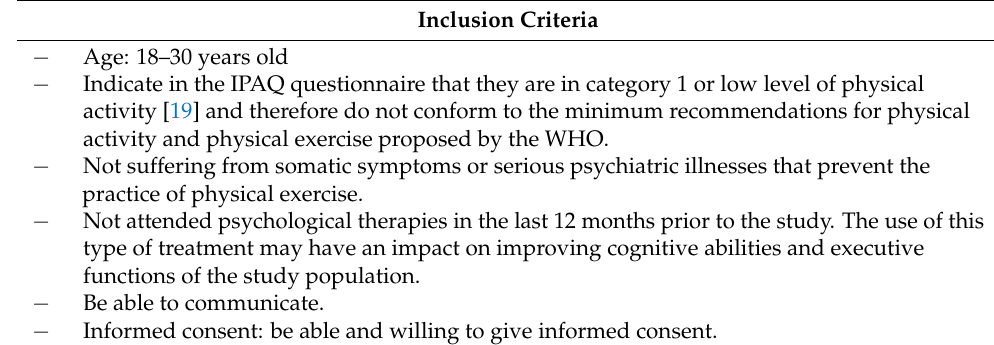
Table 1. Study inclusion and exclusion criteria.